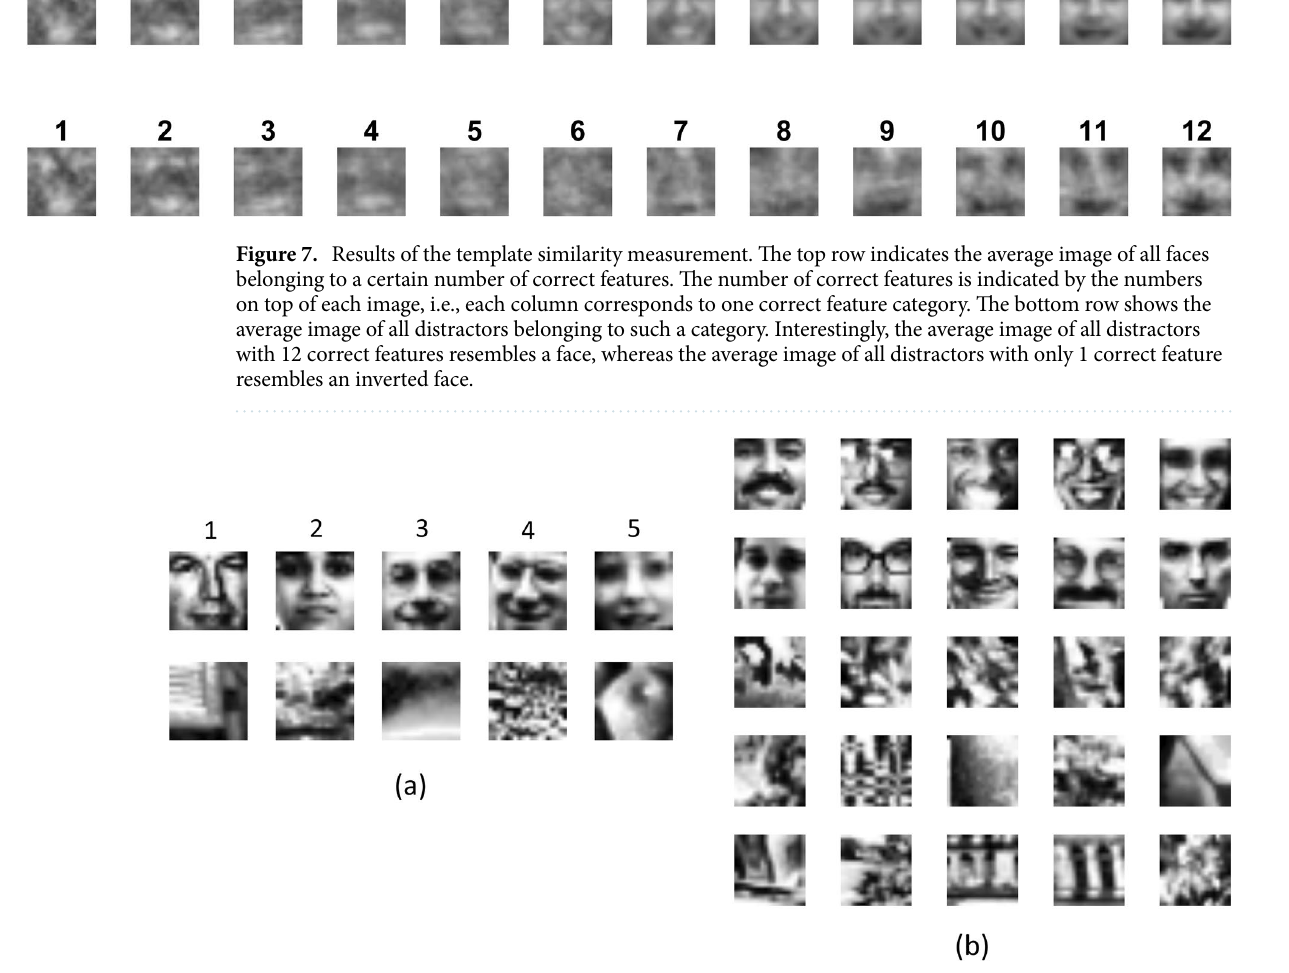
Figure 8. ( a ) The training stimulus set consists of five targets and five distractors. One group of animals received the stimulus pairs in the shown order, whereas the second group received them in reversed order to ensure that there is no effect of stimulus order. ( b ) All testing stimuli. The upper two rows visualize the testing targets (i.e., faces) with a different number of correct contrast features. The top five targets have 6 correct contrast features, whereas the bottom row of faces includes targets with 12 correct contrast features. The lower three rows visualize the testing distractors (i.e., non-faces), again with a different number of correct features (1, 6 and 12) corresponding to our